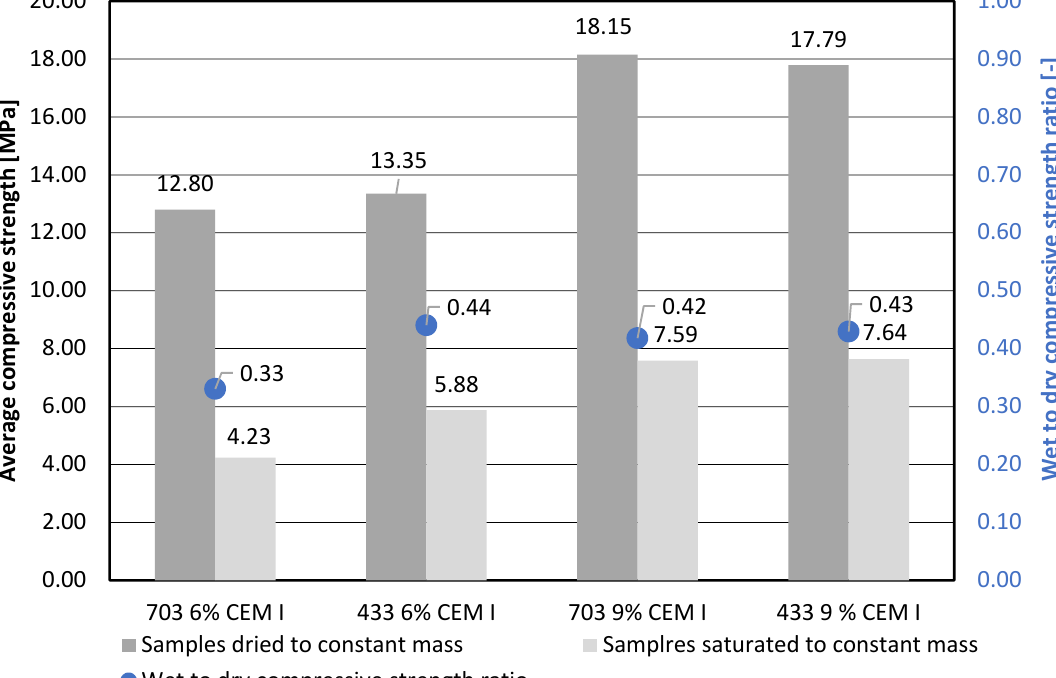
Figure 10. Average values of compressive strength of samples dried to a constant mass and saturated with water and wet to dry compressive strength ratio for rammed earth with di ff erent grain